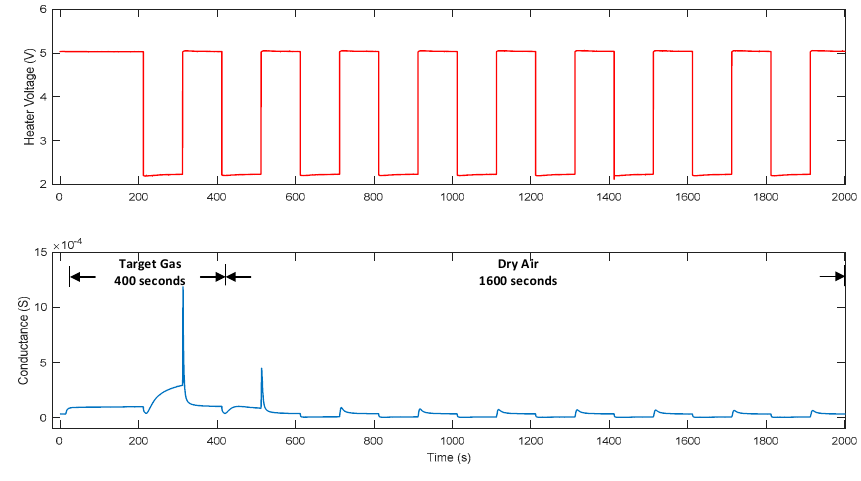
Figure 3. Experiment flow in each measurement.